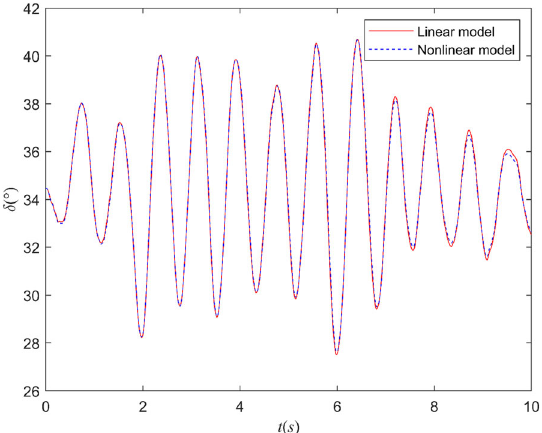
Fig. 6 Comparison of power angle curves between linear and nonlinear models of the system ( σ = 0.15)